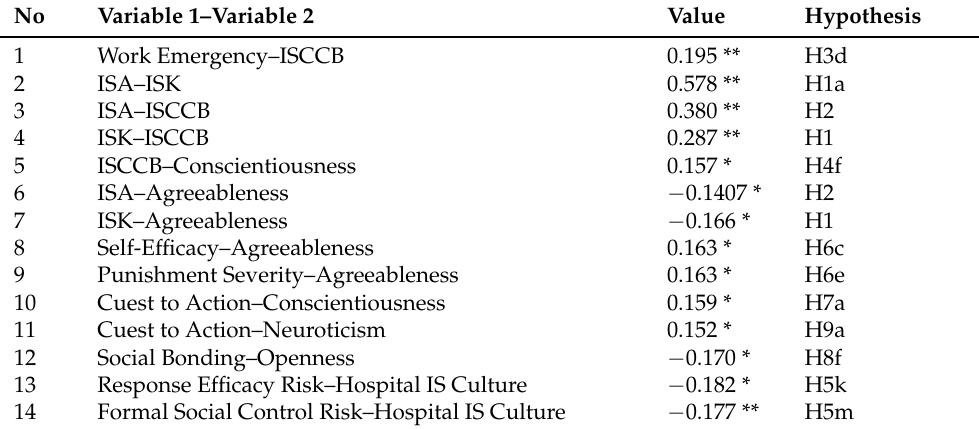
Table 12. Summary of